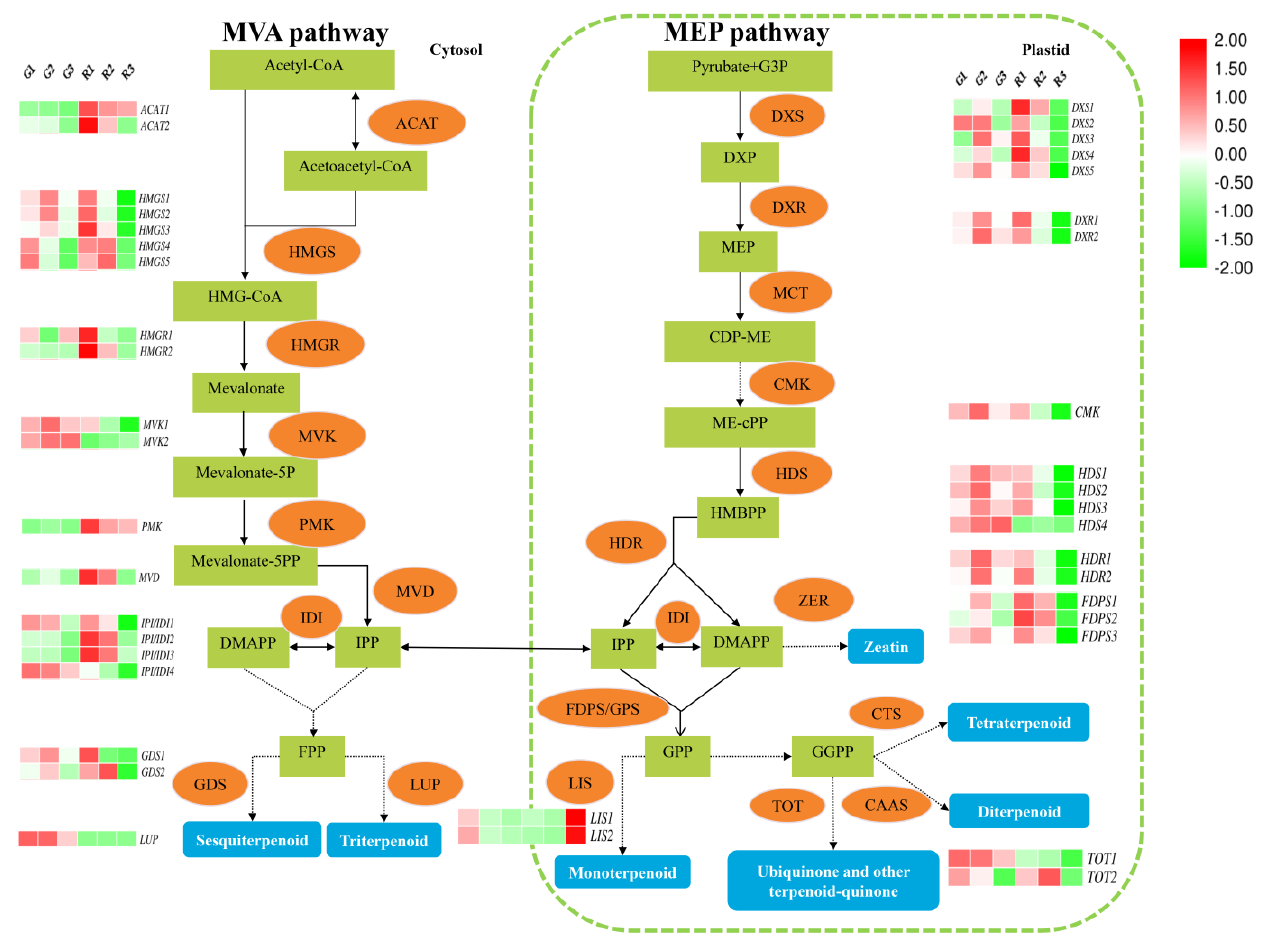
Figure 5. Expression patterns of terpene synthesis-related genes at different developmental stages of green and red prickly ash fruit. The red boxes represent genes and the green boxes represent metabolites.